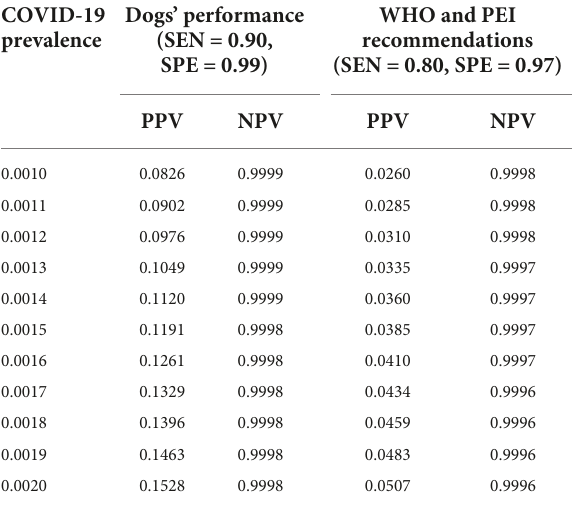
TABLE 2 Positive and negative predictive values for dogs’ performance of 90% sensitivity and 99% specificity and for the recommendations of the World Health Organization (WHO) and Paul Ehrlich Institute (PEI) among different COVID-19 prevalences in the target